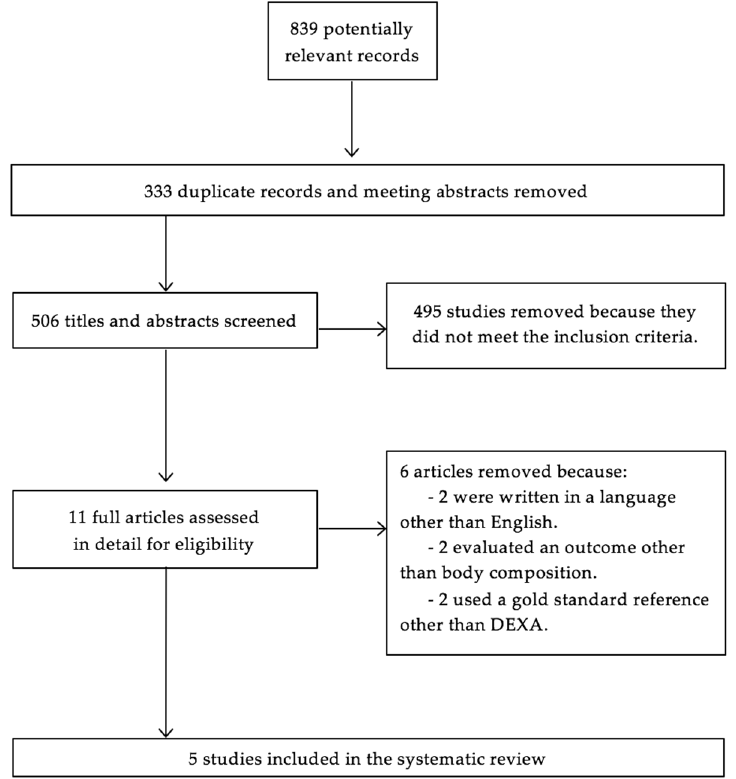
Figure 2. Flow diagram of the relevant studies selection process.